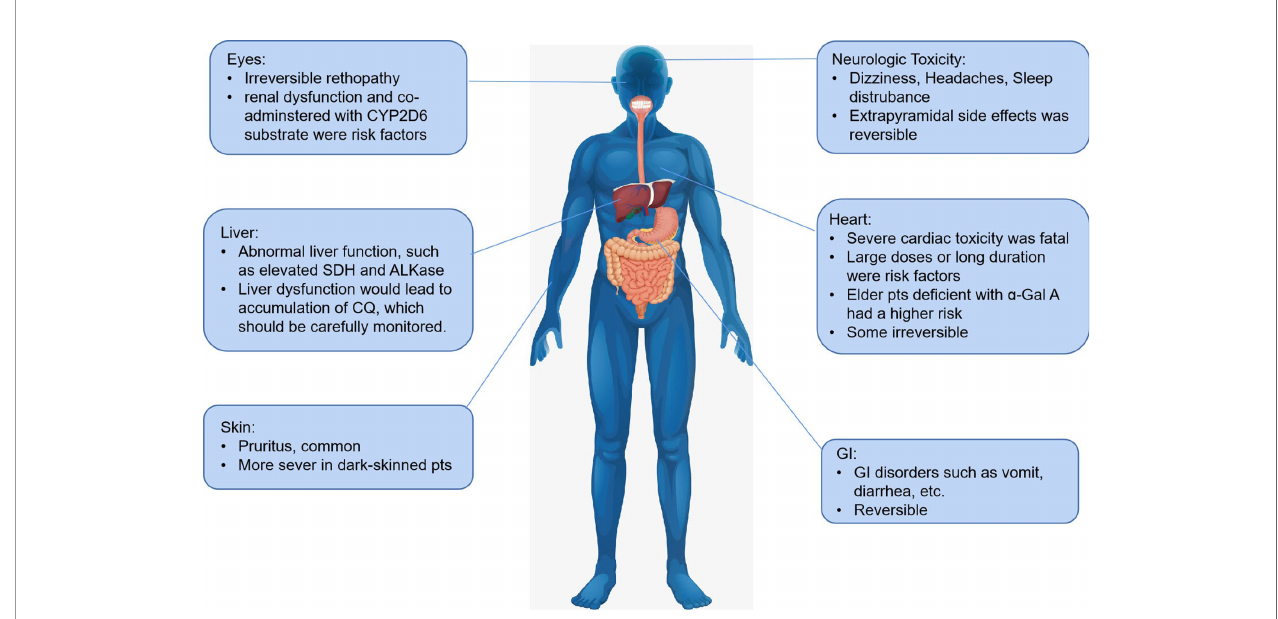
FIGURE 8 | Adverse effects induced by